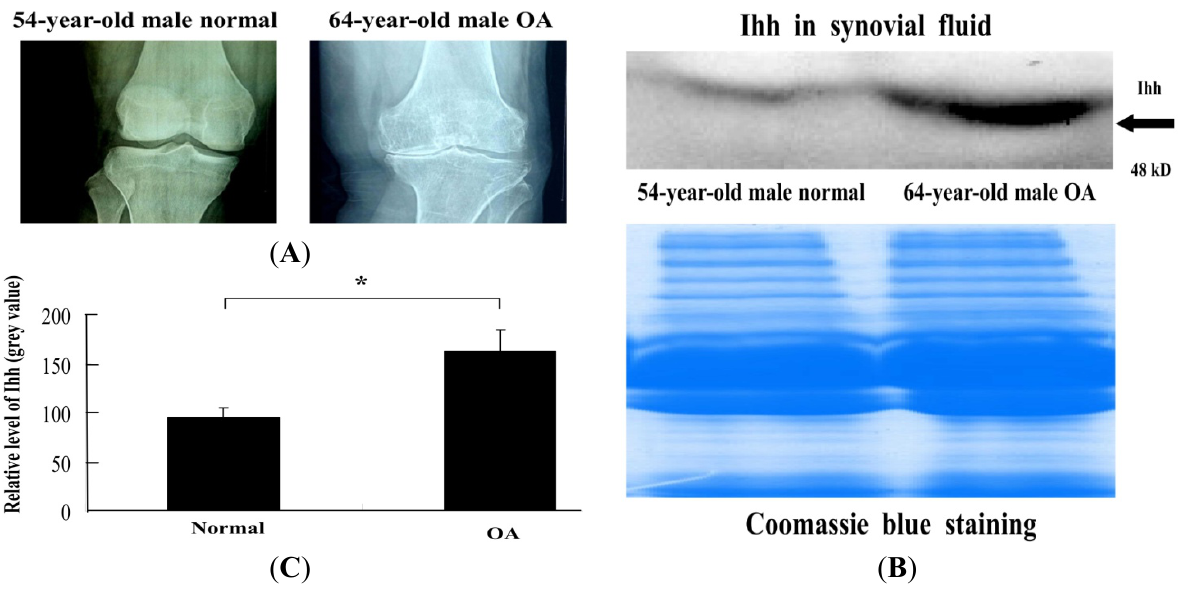
Figure 4. The increase of Ihh concentration found in OA SF. ( A ) Representative radiographs confirmed cartilage damage and joint space narrowing in the OA patients and no joint changes in the normal controls; ( B ) Representative Western blot demonstrates a high level of Ihh protein in human OA SF (64-year-old male) compared to normal control (54-year-old male healthy control). Coomassie Blue stain was used to confirm equal loading; ( C ) Gray value of Ihh band from Western blot was semi-quantified by Image Analysis